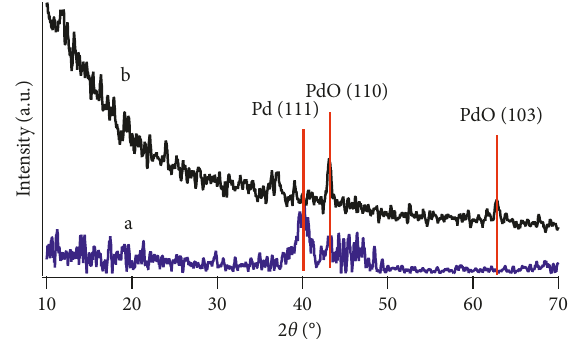
Figure 10: XRD patterns of PASGN.N catalysts before (a) and after (b) 500 scanning cycles in a (NaOH 0.5M +C 2 H 5 OH 1 M) solution at a scan rate of 50 mV · s − 1